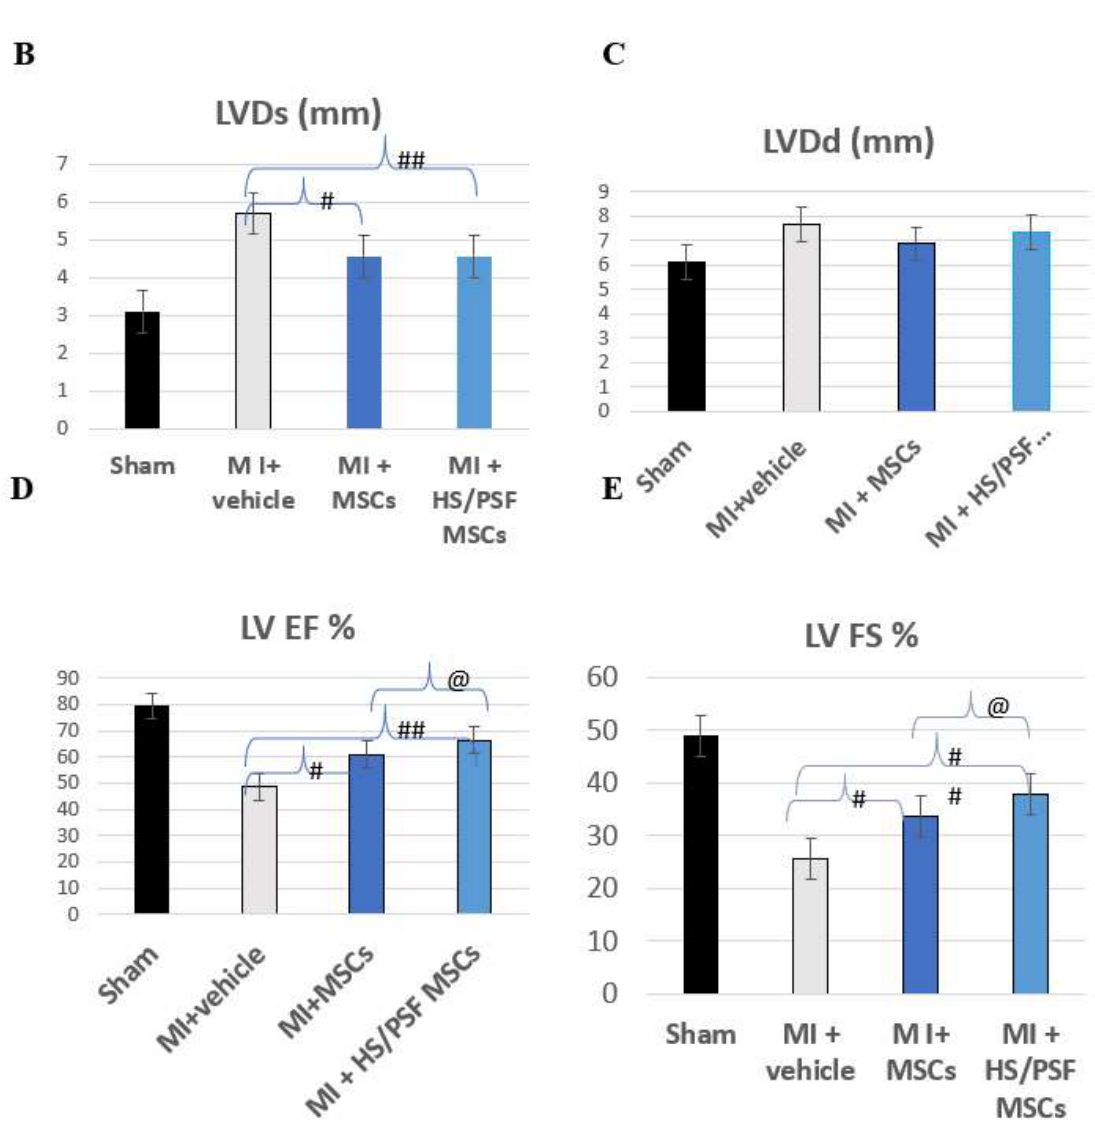
Figure 5. Echocardiography effects of untreated and HS/PSF-treated MSCs in infarct post-infarct hearts. ( A ) Representative M-mode images of four groups. Compared with Sham, MI heart showed significant LV dilatation and reduced wall motion, which was mitigated in MSC-treated hearts; ( B – E ) Compared with Sham, MI hearts showed significant increases in diastolic and systolic LV dimension (LVDd and LVDs), indicating LV dilatation, and significant decreases in LV ejection fraction (LVEF) and fractional shortening (LVFS), indicating reduced LV contractility. The LV dilatation and reduced contractility were mitigated in the two MSC treated MI groups compared with MI with the vehicle (medium) treatment. Importantly, compared with untreated MSCs, HS/PSF treated MSCs had improved LVEF and LVFS. *, ** p < 0.05 or 0.01 vs. sham; #, ## p < 0.05 or 0.01 vs. MI medium; and @ p < 0.05 compared with MI untreated MSCs. The number of animals in each group was 7 or 8, as given in Table 1. # p < 0.05 for MI + vehicle vs. MI + MSCs. ## p < 0.01 for MI + vehicle vs. MI + HS/PSF MSCs. @ p < 0.05 for MI + MSCs vs. MI + HS/PSF MSCs.